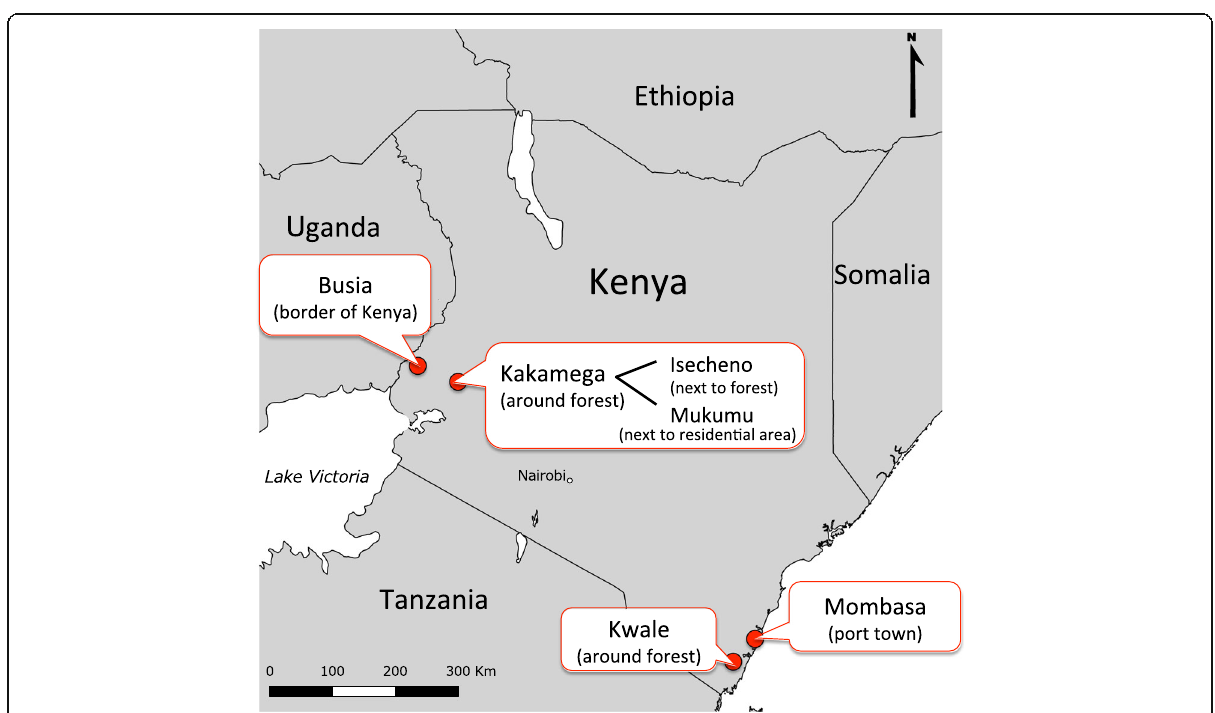
Fig. 1 Map of study region. Location of mosquito sampling site in East Kenya; Kwale, Mombasa, and in West Kenya; Busia, Kakamega (Mukumu and